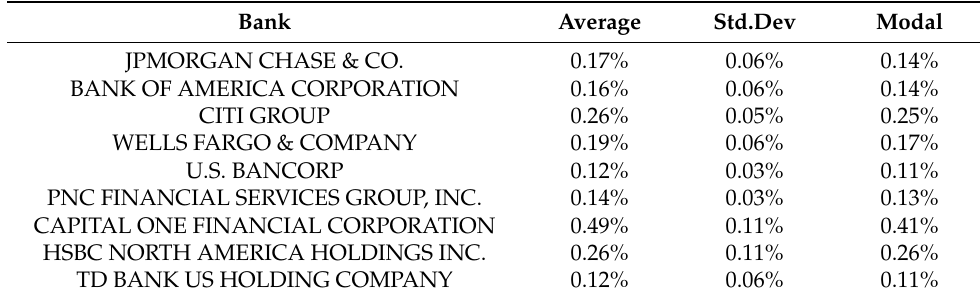
Figure 3. The correlations derived for recoveries. Source: Author’s work. Table 1. Basic statistics for recovery